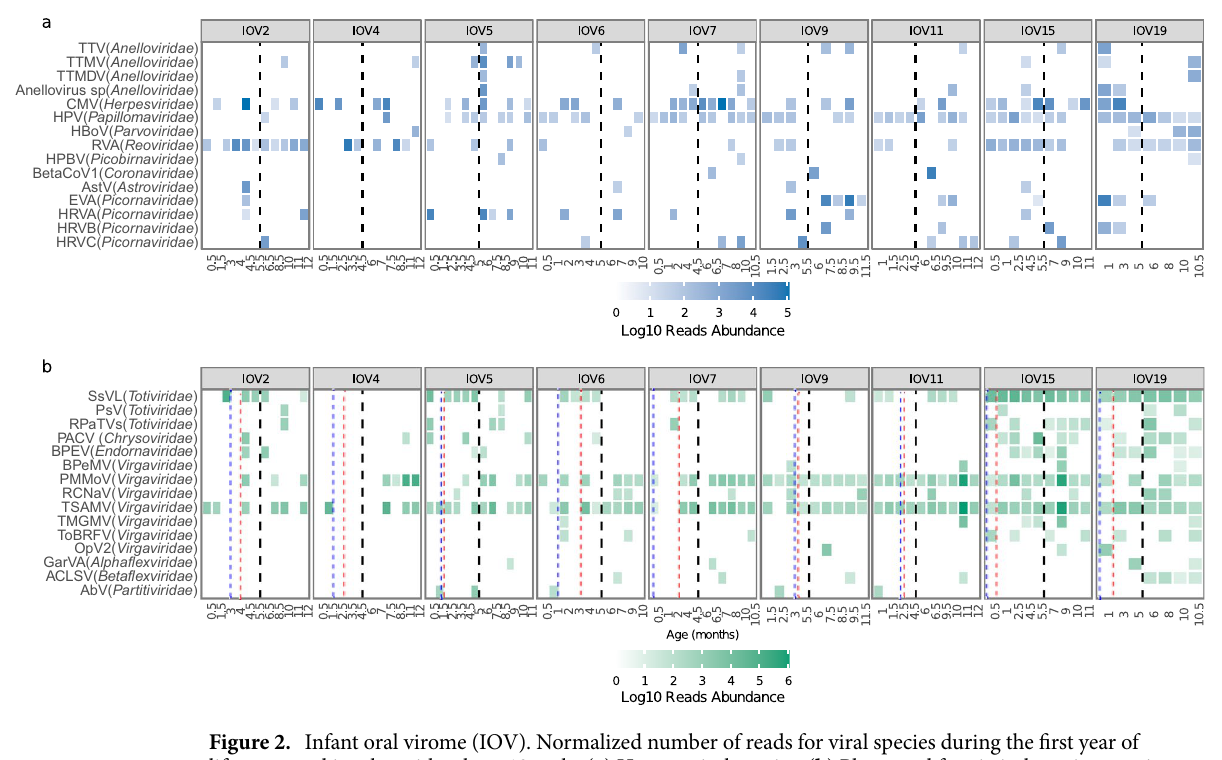
Figure 2. Infant oral virome (IOV). Normalized number of reads for viral species during the first year of life expressed in a logarithm base 10 scale. ( a ) Human viral species. ( b ) Plants and fungi viral species; species categorized as ‘sp.’ in Supplementary Table S3 were omitted from this figure. The family to which each species belong is shown in parenthesis. Each panel illustrates a child, with the identifier IOV at the top, and the age in months at the bottom. Black dotted lines divide the first and second halves of the first year of life. Blue dashed lines indicate the introduction of liquids other than milk, and red dotted lines the introduction of fruits, and in some cases vegetables. Species that infect humans: TTV, torque teno virus; TTMV, torque teno mini virus; TTMDV, torque teno midi virus; CMV, cytomegalovirus; HPV, human papillomavirus; HBoV, human bocavirus; RVA, rotavirus A; HPBV, human picobirnavirus; BetaCoV1, betacoronavirus 1; EVA, enterovirus A; Ast, astrovirus; HRVA, rhinovirus A; HRVB, rhinovirus B; HRVC, rhinovirus C. Species that infect plants: SsVL, Scheffersomyces segobiensis virus L; PsV, Puccinia striiformis totivirus; RPaTVs, red clover powdery mildew- associated totivirus; PACV, Persea americana chrysovirus; BPEV, bell pepper alphaendornavirus; BPeMV, bell pepper mottle virus; PMMoV, pepper mild mottle virus; RCNaV, rattail cactus necrosis-associated virus; TSAMV, tropical soda apple mosaic virus; TMGMV, tobacco mild green mosaic virus; ToBRFV, tomato brown rugose fruit virus; OpV2, opuntia virus 2; GarVA, garlic virus; ACLSV, apple chlorotic leaf spot virus; AbV, Agaricus bisporus